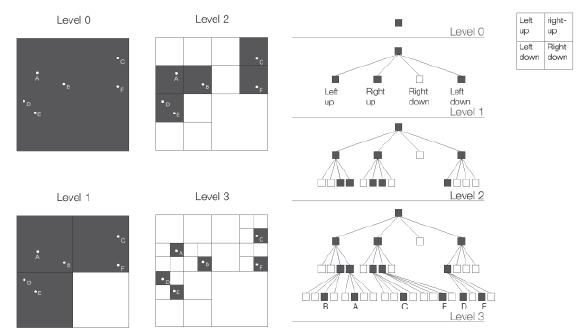
Figure 2: Subdivision of a quadtree, large empty space can be constructed out of a single quadrant.